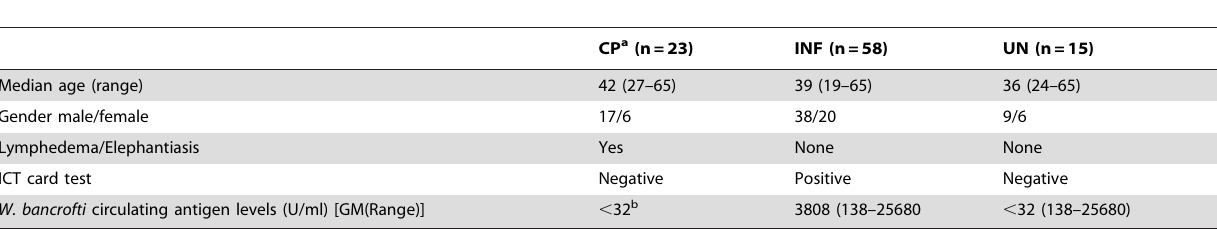
Table 1. Characteristics of the study